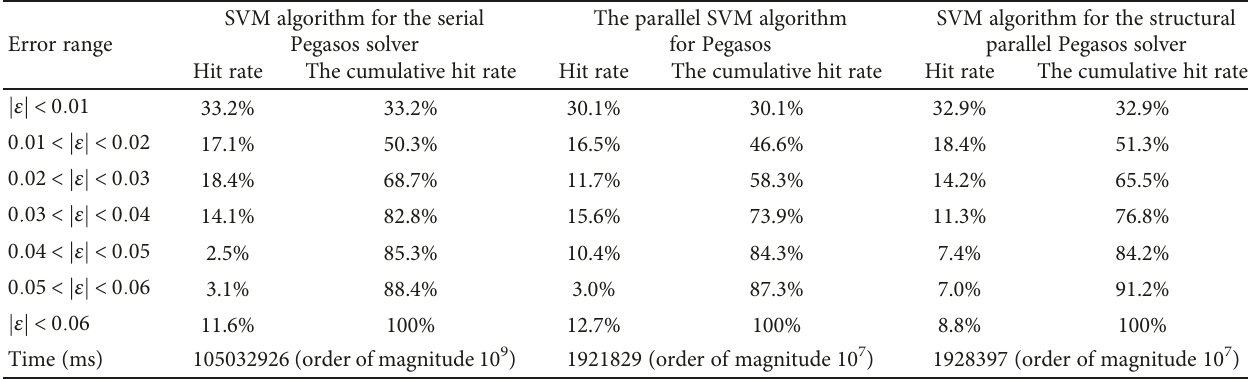
Table 3: Statistical table of dynamic prediction of the [Si]% value of three di ff erent algorithms. Error range